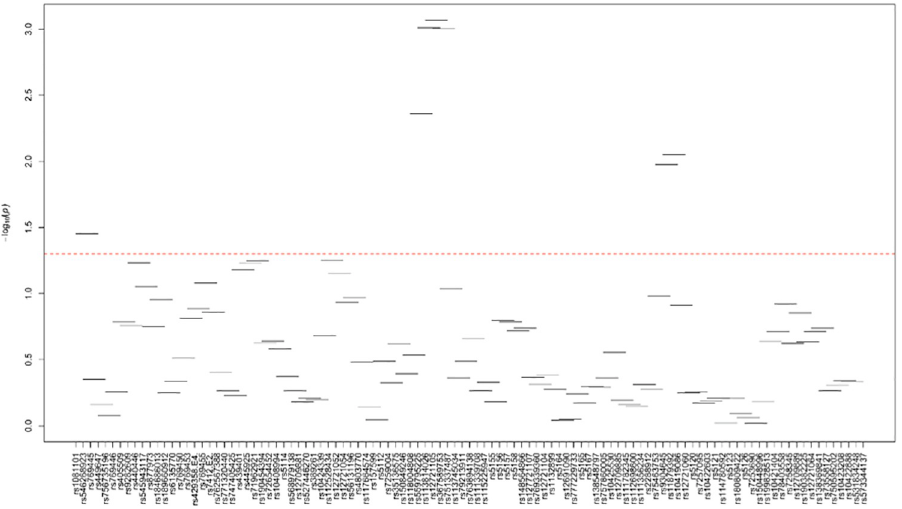
Fig 12. Plots of haplotype-based association analysis results for TG in African blacks. Horizontal lines represent the 4-SNP windows. X-axis shows the SNPs genotyped in the regions based on the order of APOE , APOC1 , HCR1 , HCR2 , APOC4 and APOC2 while the Y-axis shows the–log (global p-value) with red line representing the p-value threshold (P =